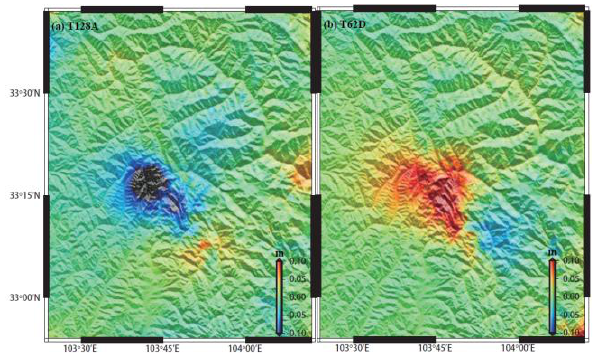
Figure 2. (a) Coseismic deformation of ascending rail for Jiuzhaigou earthquake; (b) Coseismic deformation of descending rail for Jiuzhaigou earthquake.